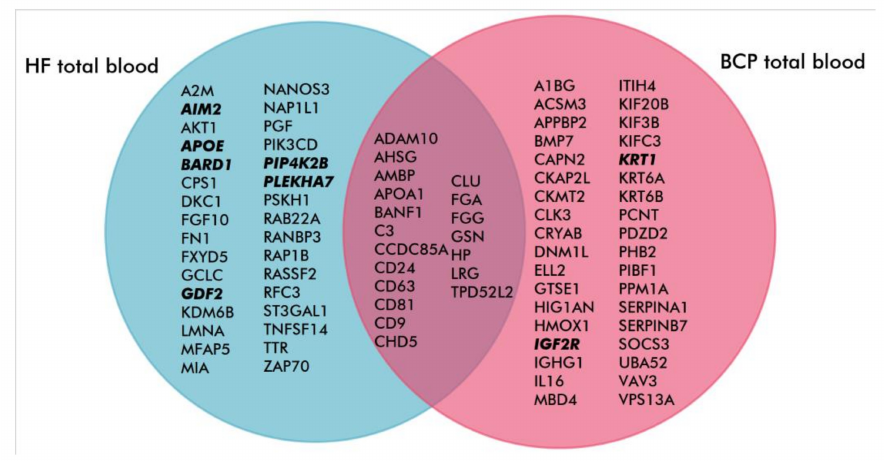
Figure 6. Venn–Euler diagram of exosomal proteins associated with invasion (blood from HFs and BCPs). Proteins that suppress invasion are in bold.